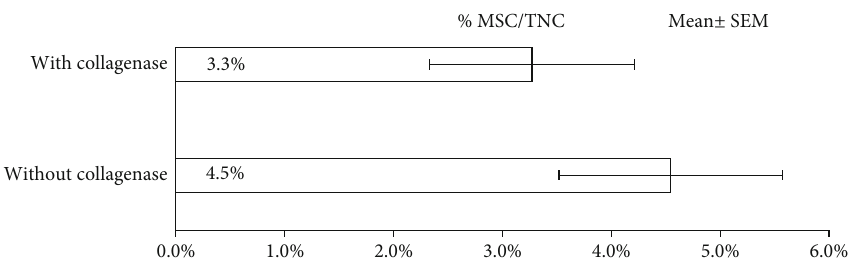
Figure 5: Percentage of mesenchymal stem cells per total nucleated cells (MSC/TNC) in the SVF of adipose tissue when treated with or without collagenase ( n = 11 ). Table 5: MSC from adipose tissue: comparison of MSC isolated from living and deceased donors. Adipose